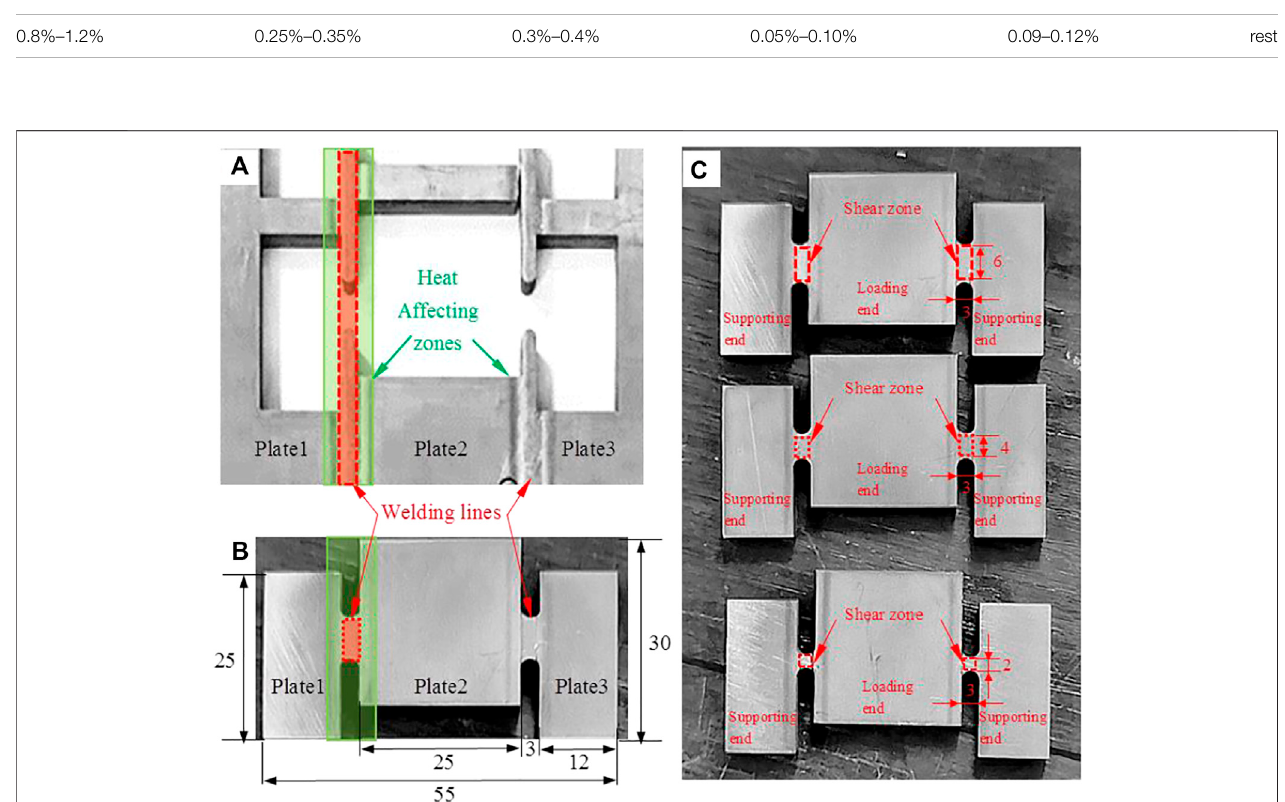
TABLE 1 | Chemical composition (wt%) of the Zr – Sn – Nb alloy plate. Sn Nb